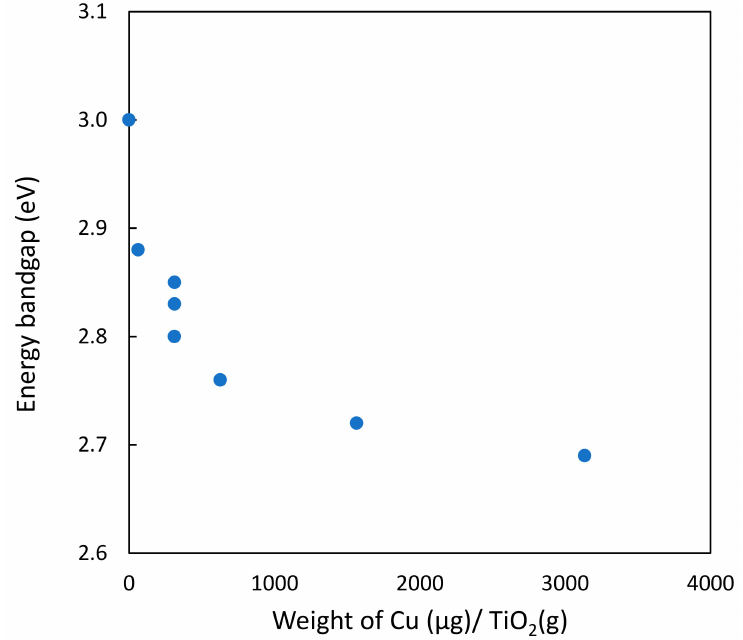
Figure 5. Cu loading dependence of energy band gap.